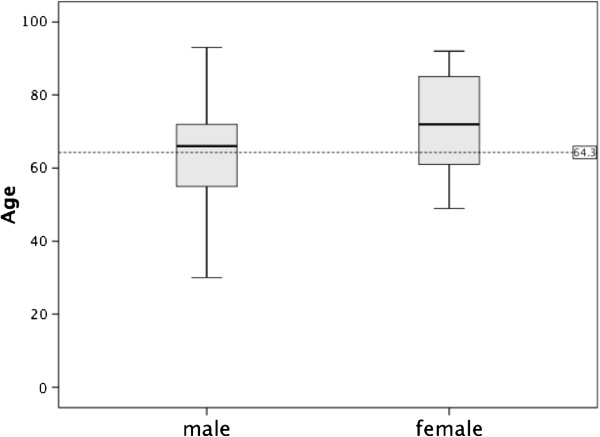
Box-and-whisker plot of age as a function of sex of patients with CSDH. The lines demarcate the median and inter-quartile range, and the whiskers indicate the upper and lower limits of the data. The dashed line demarcates the mean age (in years) of 778 patients who underwent CSDH operations in Neurosurgical Services at the Hospital de Base do Distrito Federal, Brasília, Brazil.